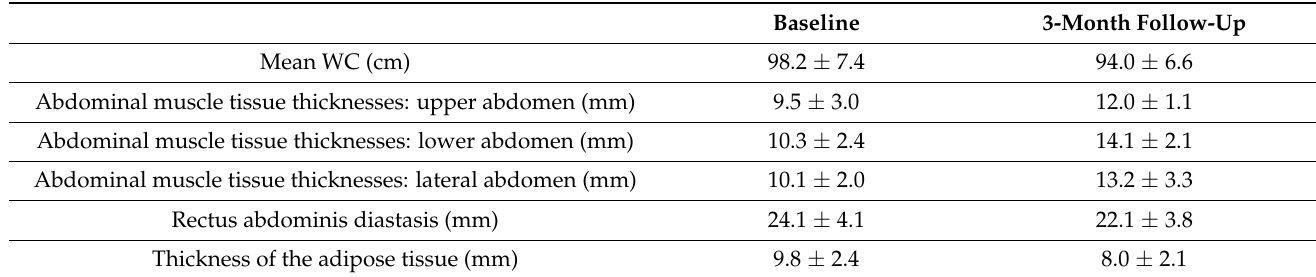
Table 2. Mean values of study parameters at baseline and 3-month